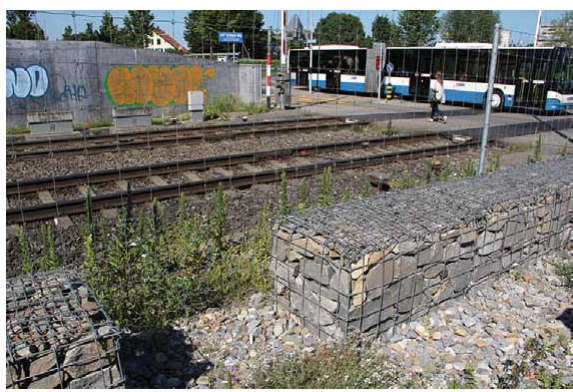
fig. 4. low Impact Design practice example (rain garden) in Seattle (uSa)